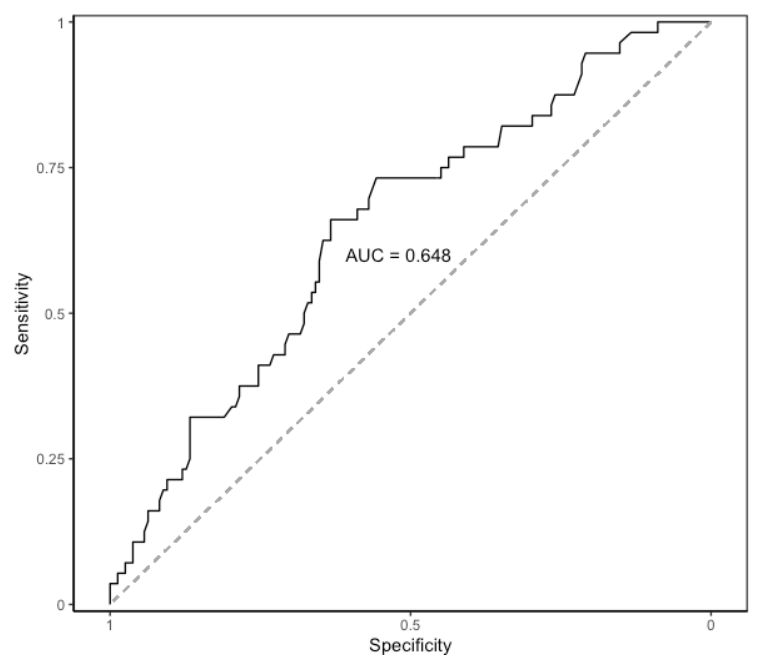
Figure 2. Area under the ROC curve of CRP on postoperative days 2 and 3. AUC: area under the ROC curve. ROC: receiver operating characteristic. CRP: C-Reactive Protein.